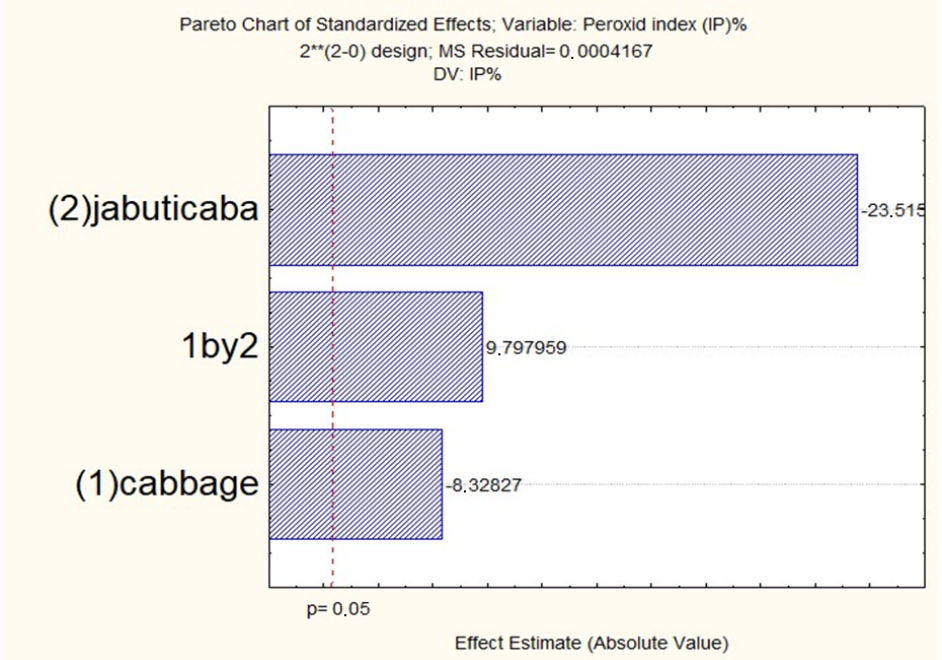
Figure 2. The Pareto graphic indicating the jabuticaba and cabbage extracts effect ( p < 0.05) on cheeses’ (assays 1–6) peroxide index increase (%) after 9 days-storage.